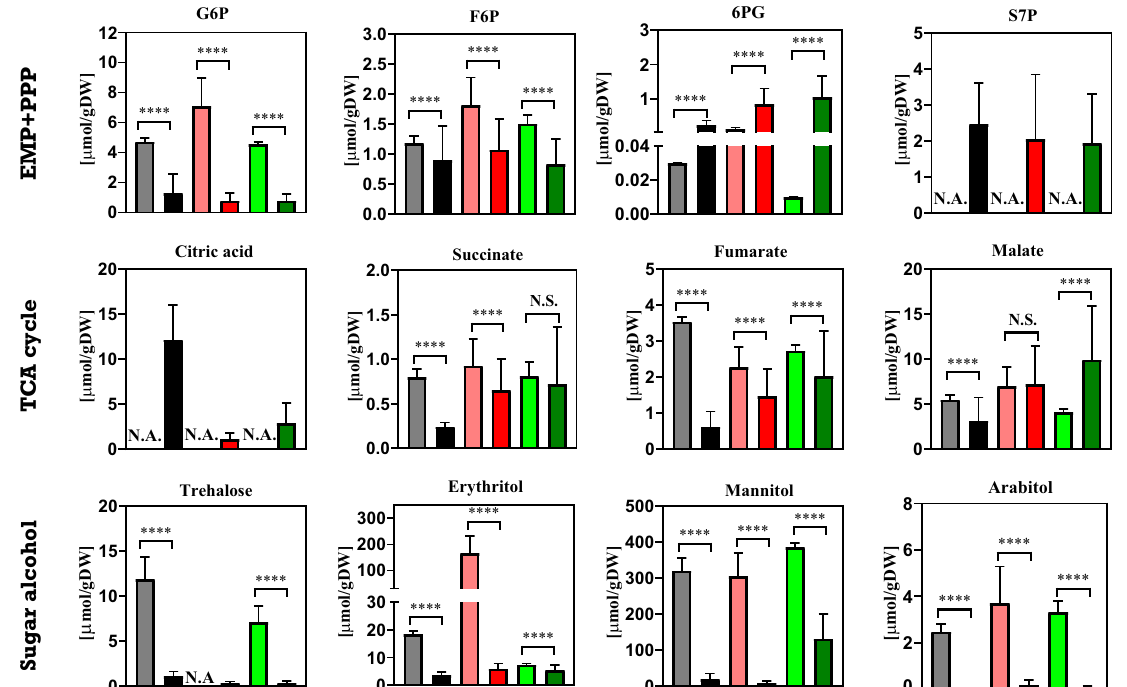
Figure 8. Intracellular amount of sugar phosphates, organic acids and sugar alcohols in Penicillium chrysogenum Wisconsin 54-1255, Penicillium chrysogenum ∆ tps1 and Penicillium chrysogenum ∆ tps2 strains under both steady state conditions and feast/famine conditions. Under steady state conditions, samples were taken at each residence time and datasets were collected from triplicate experiments, while under rapid feast/famine conditions, samples were rapidly taken within a feeding cycle time of 6 min twice for each experiment. The datasets are shown as average value ± standard deviation. The numbers of data points for the steady state conditions and feast/famine conditions are 30 and 32, respectively. A two-tail Student’s t -test was conducted * p < 0.05 (significant) and **** p < 0.01 (extremely significant) versus WT using GraphPad Prism 8. N.A., not available. (cid:122) WT steady state conditions; (cid:122) WT feast/famine conditions; (cid:122) ∆ tps1 steady state conditions; (cid:122) ∆ tps1 feast/famine conditions (cid:122) ∆ tps2 steady state conditions; (cid:122) ∆ tps2 feast/famine conditions. The results from steady state conditions were obtained from Wang et al. (2019) [24]. Abbreviations: G6P, glucose-6-phosphate; F6P, fructose-6-phosphate; 6PG, 6-phosphogluconate; S7P, sedoheptulose-7-phosphate; EMP, Embden–Meyerhof–Parnas; PPP, Pentose phosphate; TCA, tricarboxylic